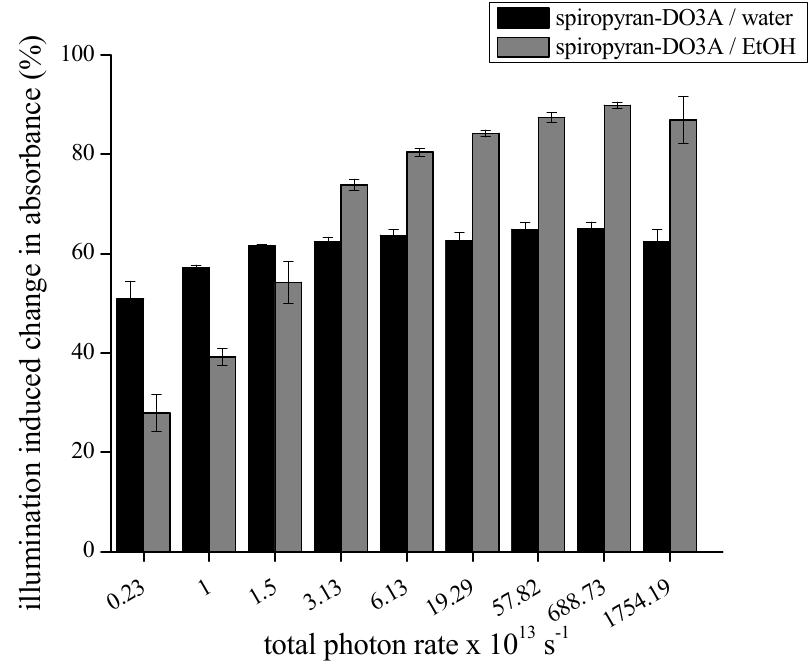
Figure 3. Determination of maximum illumination-induced peak absorbance change in relation to the photon emission rate: The maximum peak absorbance change of spiropyran- DO3A-Gd dissolved in water and ethanol for different photon emission rates intensities was determined after illumination with the blue LED. The total photon emission rate was calculated using Equation